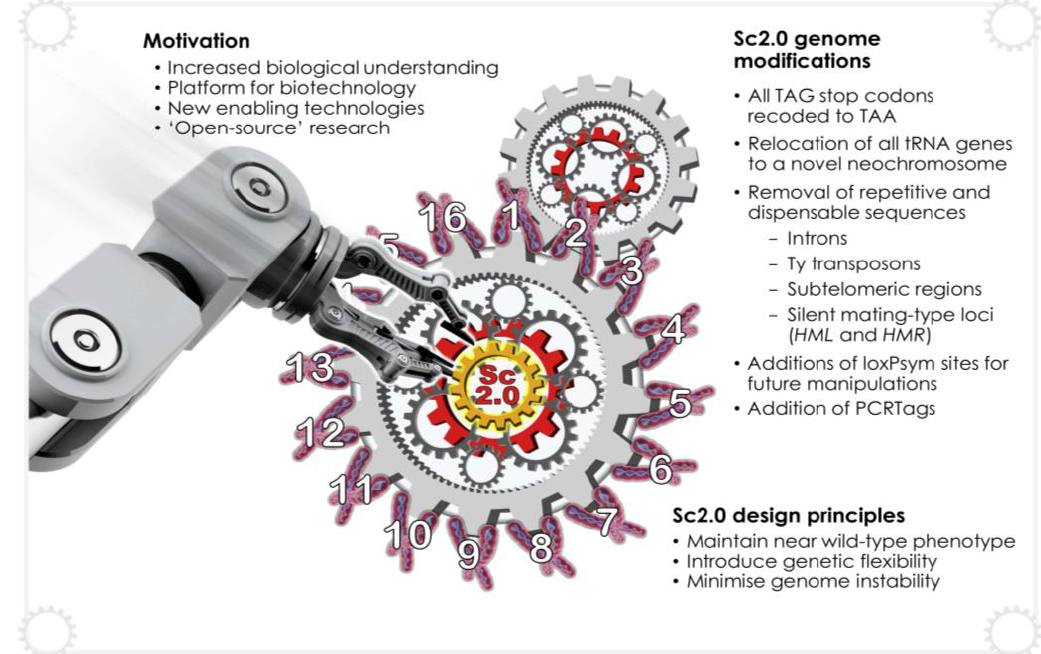
Figure 7. The Synthetic Yeast (Sc2.0) consortium is undertaking rapid progress towards the construction